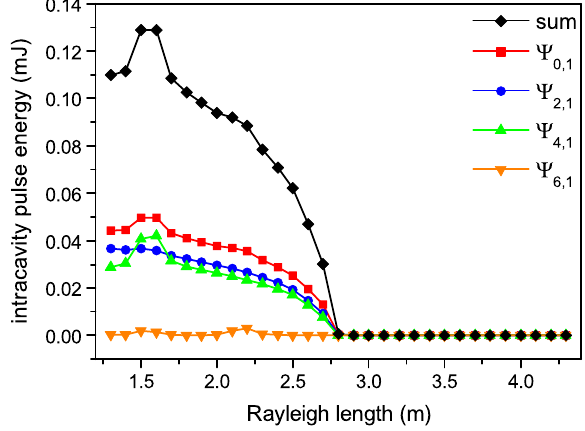
FIG. 4. Intracavity pulse energy as a function of the Rayleigh length calculated for different Ψ